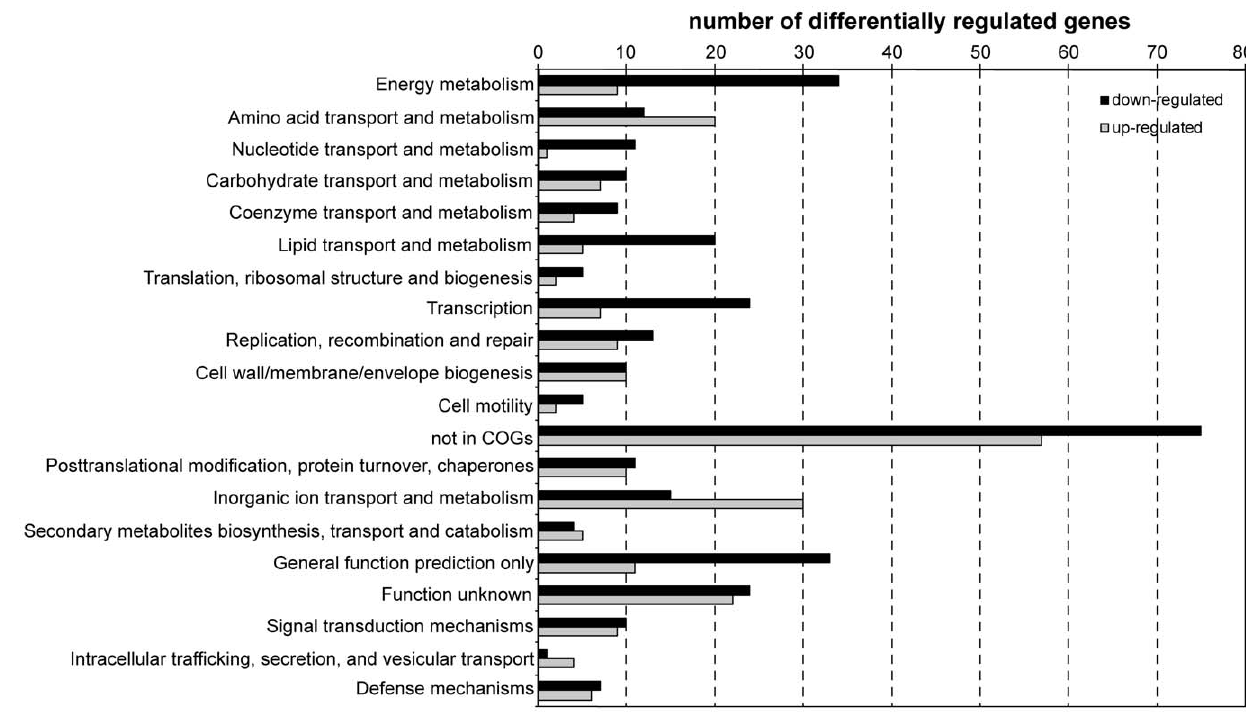
Figure 2. Functional categories of significantly regulated genes comparing cells attached for 60 minutes to cells attached for 15 minutes. Up-regulated genes are displayed in light grey, downregulated genes in black. The only two functional groups that are comprising more genes that are upregulated than downregulated are those of transport and metabolism of amino acids and inorganic ions, in particular iron, respectively.